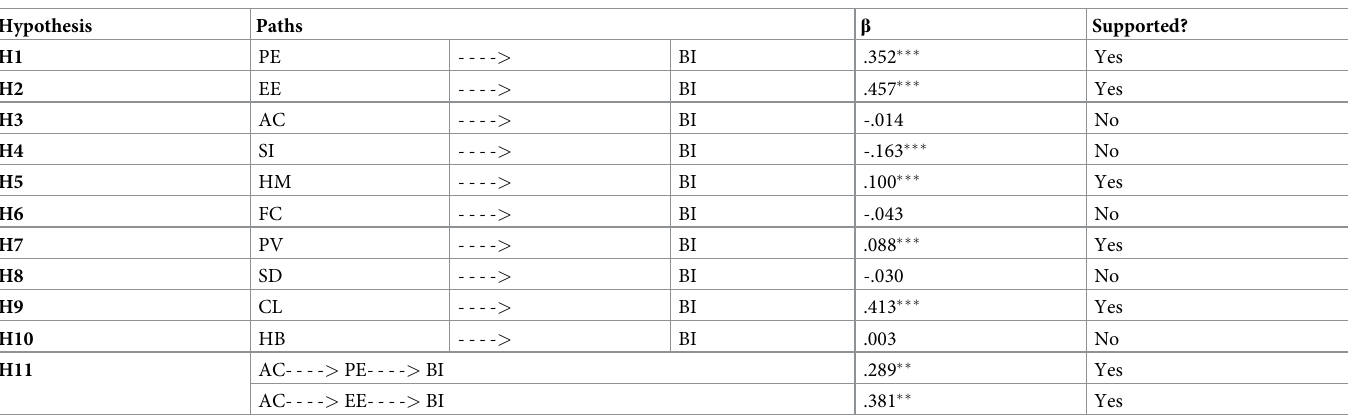
indicated that β = 0.003, p > 0.01 which led to the rejection of hypothesis 10. The results of the tested hypotheses have been summarized in Table 5. 3.4.2. SEM analysis for Thailand. Fig 3 and Table 6 evaluated the hypothesis for the case of Thailand. The results of the data indicated that among the variables evaluated, several hypotheses were supported. The supported hypothesis were the path coefficient between EE and BI for hypothesis 2 ( H2 ) ( β = 0.511, p < 0.01); path coefficient between SI and BI for hypothesis 4 ( H4 ) ( β = 0.143, p < 0.01); the path coefficients between FC and BI for hypothesis 6 ( H6 ) ( β = 0.262, p < 0.01); path coefficients between SD and BI for hypothesis 8 (H8) ( β = 0.110, p < 0.01); and path coefficients between SD and BI for hypothesis 9 (H9) ( β = 0.475, Table 5. SEM analysis for